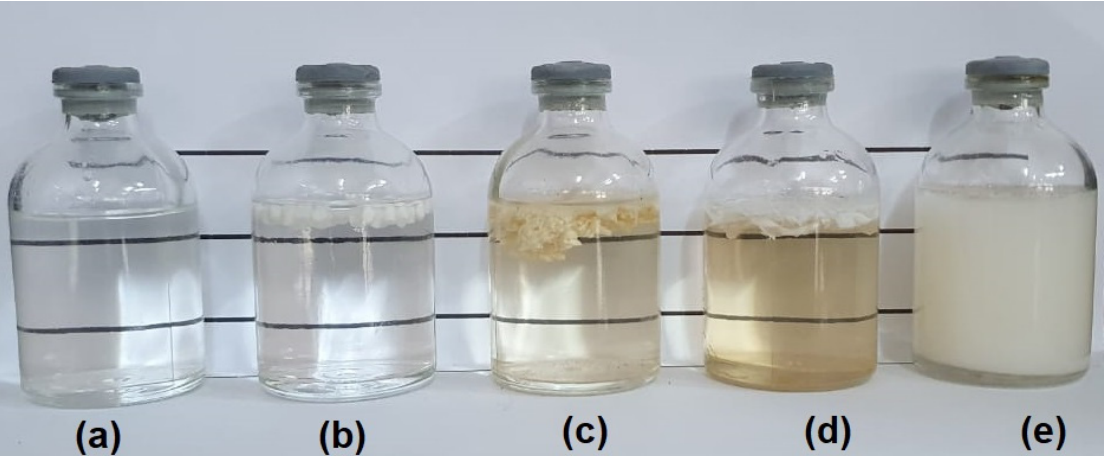
Figure 4. Molau test solutions in formic acid for ( a ) pure PA6; ( b ) ABS; ( c ) ABS-MA; ( d ) PA6/ABS (90/10%); ( e ) PA6/ABS-MA (90/10%).